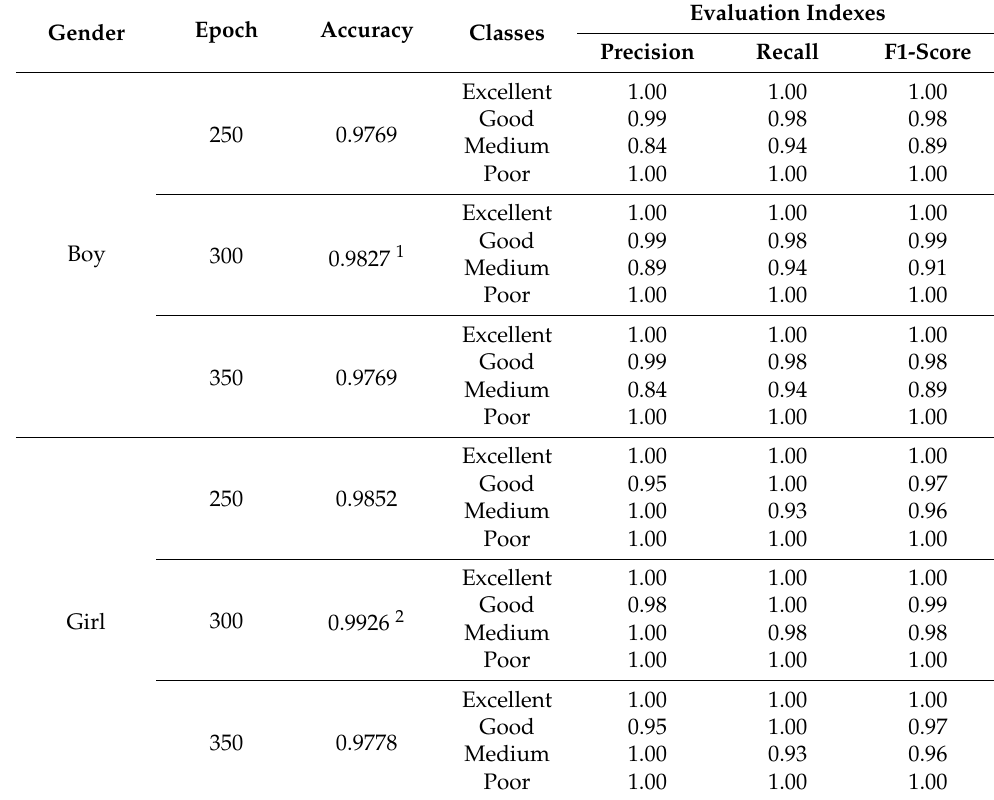
Table 7. Evaluation indexes for teenagers’ physical fitness levels.